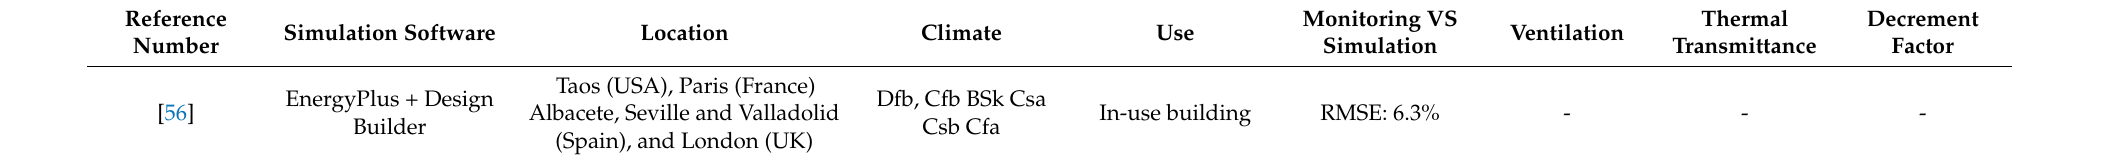
Table 17. Building characteristics and thermal performance of the earthship simulated